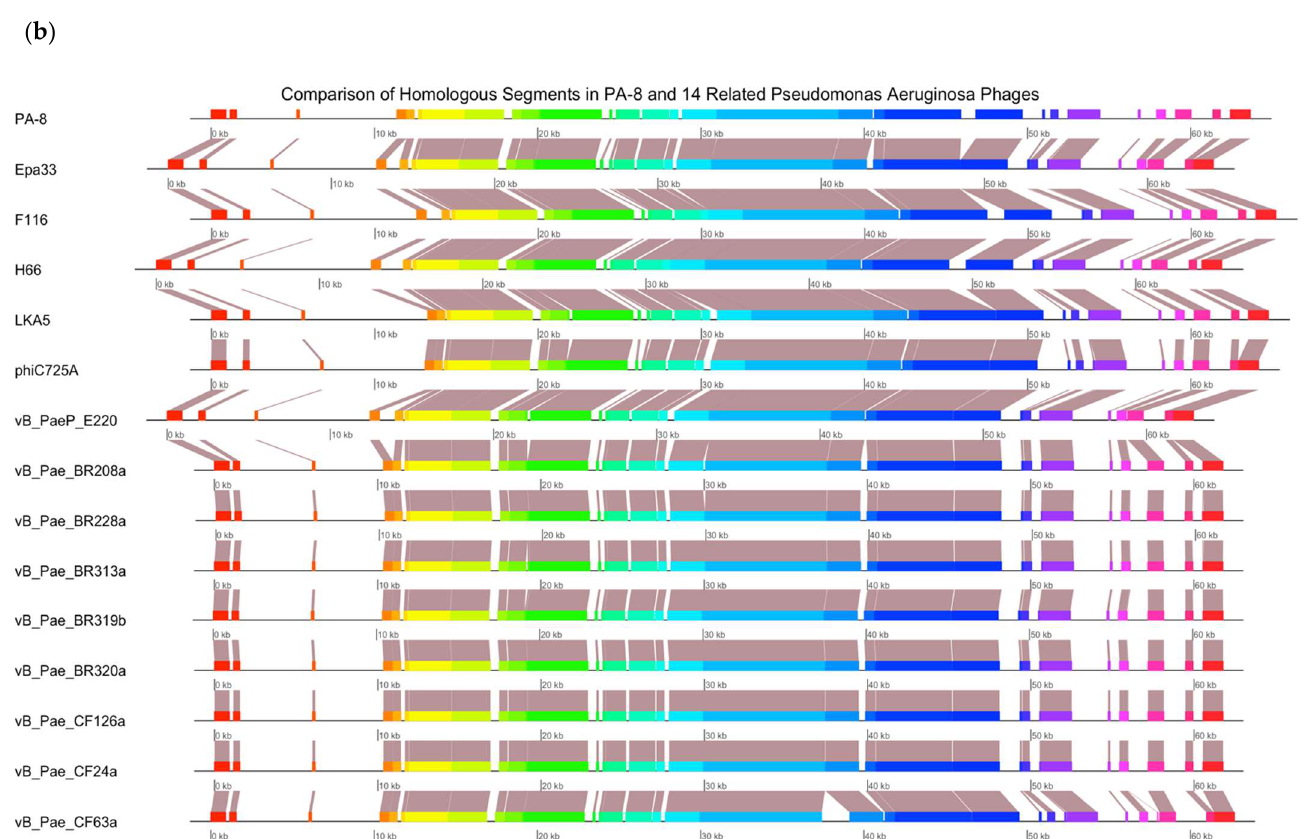
Figure 7. Bacteriophage Genome Sequence Analysis. Schematic genome alignment diagram of ( a ) PA4 and 18 closely related P. aeruginosa phages and ( b ) PA8 and 14 closely related P. aeruginosa phages, obtained using the Mauve software package and plotted using genoPlotR. Phages in figure ( a ) were oriented to begin at the thyx gene, whilst phages in figure ( b ) were oriented to begin at the rdgC recombinase gene to assist the visual interpretation. The coloured blocks are homologous nucleotide regions, whereas the white spaces and gaps indicate regions that are different between phages.